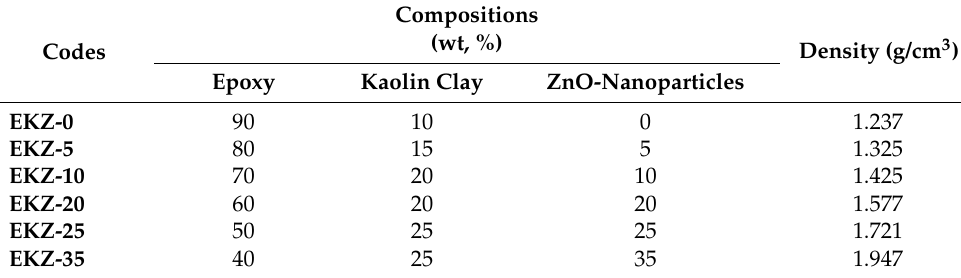
Table 3. Chemical compositions of pioneer epoxy